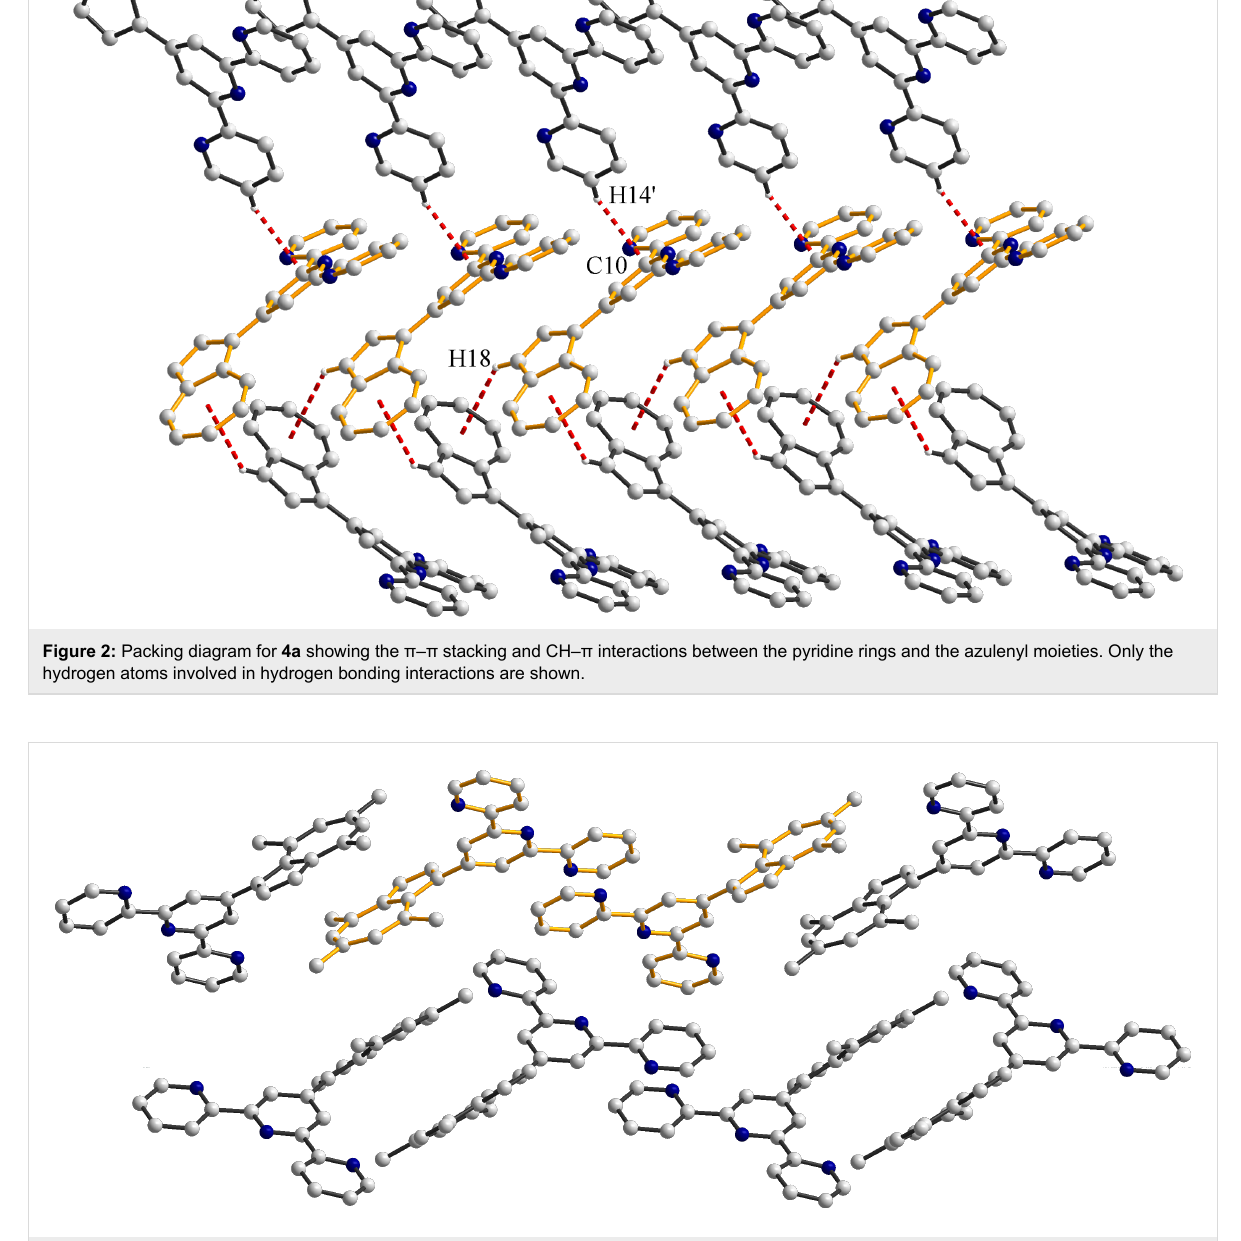
an absorption maximum at 279 in dichloromethane solution